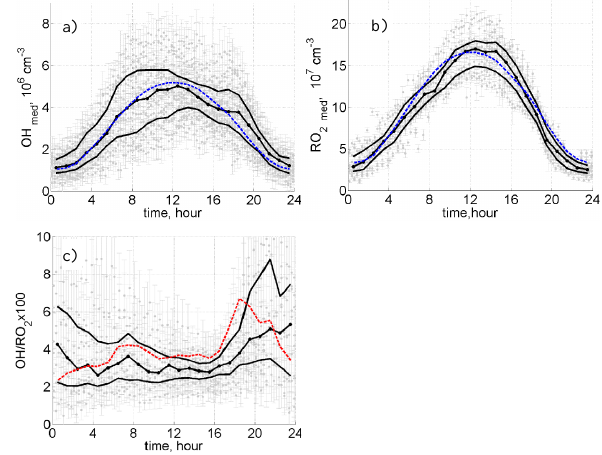
Figure 2. Median diurnal concentration profiles of OH (a) , RO 2 (b) , [OH] / [RO 2 ] ratio (c) . Solid lines represent the median and quar- tile levels. Points – 15min averaged measured values with standard deviations. Blue line in (a) and (b) represents J (NO 2 ) in arbitrary units. Red line in (c) represents median